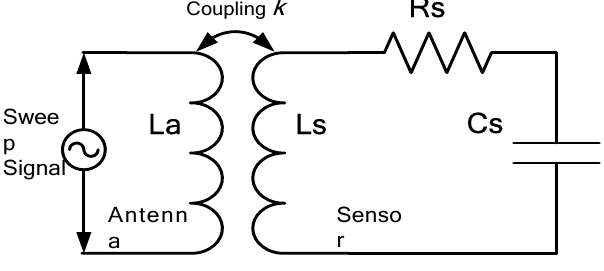
Figure 3. Equivalent measurement principle of the fabricated sensor.